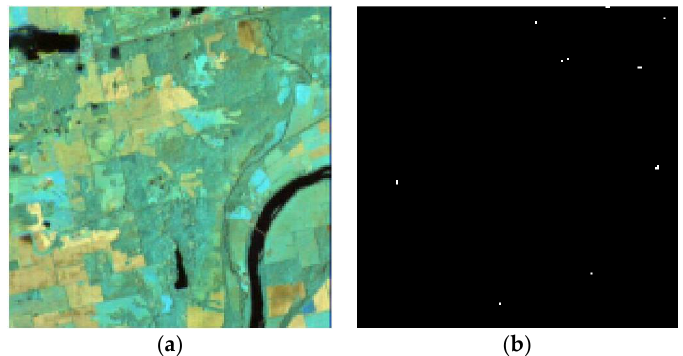
Figure 11. Hyperion data: ( a ) pseudocolor image (Bands 120, 80, and 40 for RGB); and ( b ) ground truth.